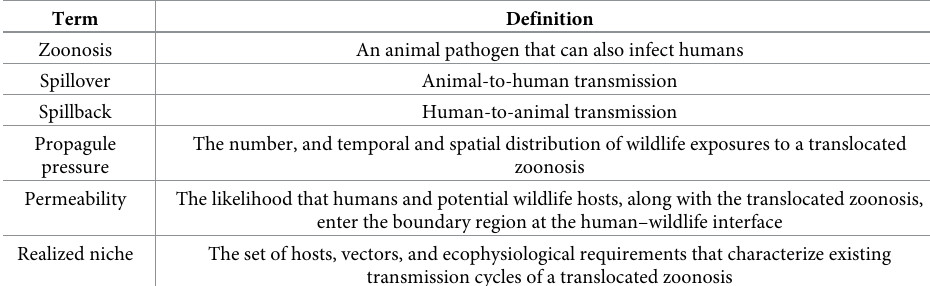
Table 1. Definitions of terms used in this